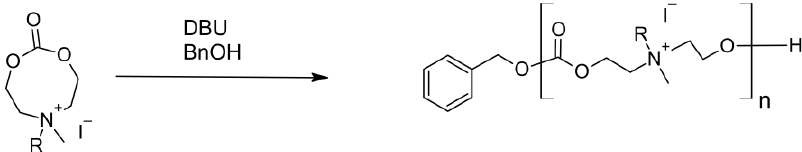
Figure 18. Direct ROP of quaternized cyclic carbonate.